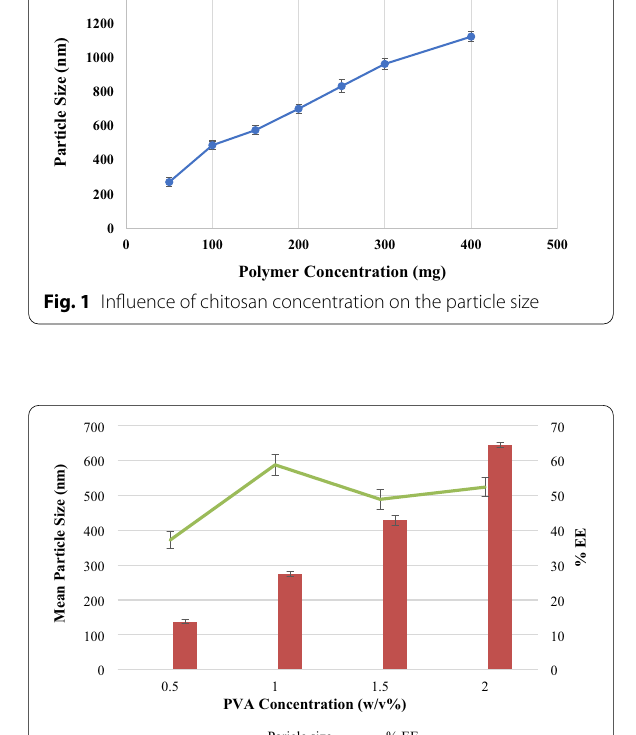
Influence of PVA concentration in the aqueous phase From the studies, it was shown that by increasing the sta- bilizer (PVA) concentration from 0 to 2%, particle size increases continuously. The PFD concentration (100 mg) and chitosan concentration (100 mg) were taken con- stantly for all batches. The volume of the aqueous phase was taken as constant with modification by increased stabilizer concentration. The PVA effect is obtained as a stabilizer as well as an emulsifying agent in the emulsion. Nanoparticles will form if the stabilizer persists at the liquid–liquid interface during the diffusion process and its protective action is enough. The results are shown in Fig. 2. The effects of PVA content in the aqueous phase on particle size are shown in Fig. 2. Because of the high aqueous phase viscosity, when the PVA concentrations increase, the particle size steadily increases, reducing the total shear stress accessible for droplet breakdown. Swelling behavior was increased with the increasing concentration of polyvinyl alcohol [31]. The increased concentration of hydroxyl groups in the PVA as the con- centration of PVA increases which directly effect on pir- fenidone binding proportion.